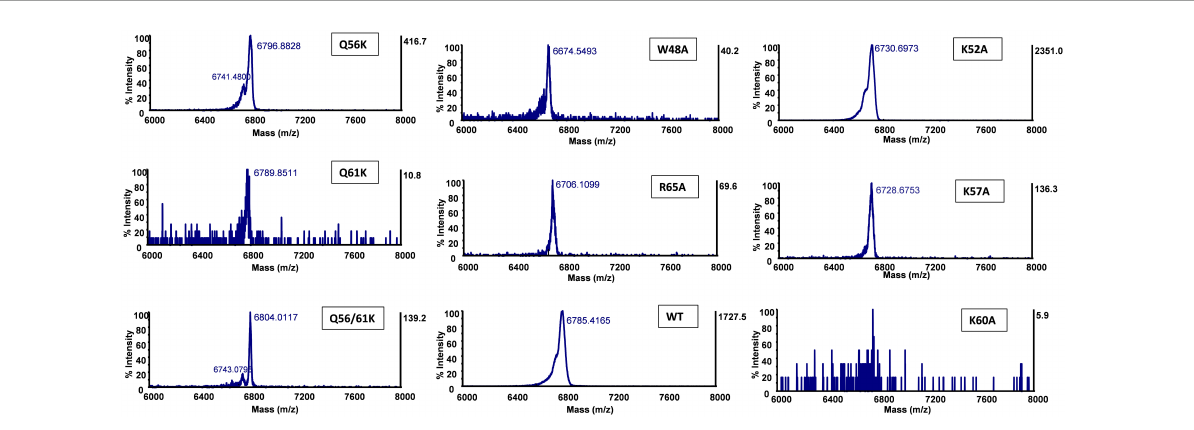
FIGURE5 Matrix-assisted laser desorption/ionization-time of flight (MALDI-TOF) spectra of circularin A and variants. No calibration sample for MALDI-TOF detection was performed in this assay. The detected mass values are slightly different from their theoretical masses. So we evaluate the production of mutant peptides by comparing the mass reduction between the wild-type (WT) circularin A and the variants in Table 3